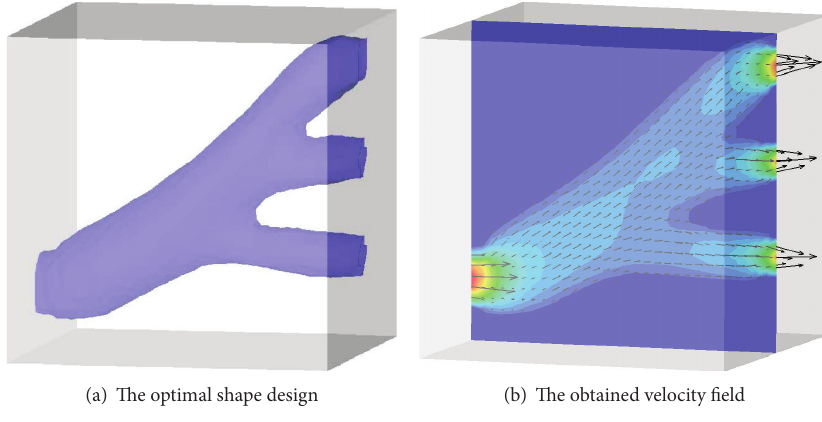
Figure 6: Second case: a cavity with one inlet and three outlets.